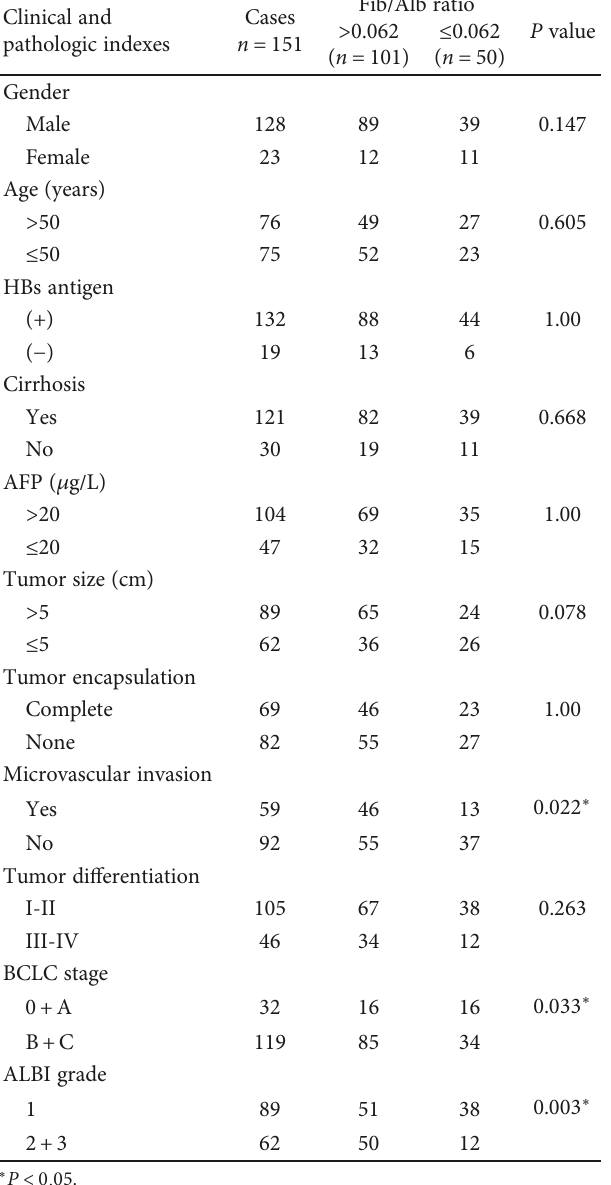
Table 1: Relationship between preoperative Fib/Alb ratio and clinicopathological characteristics.